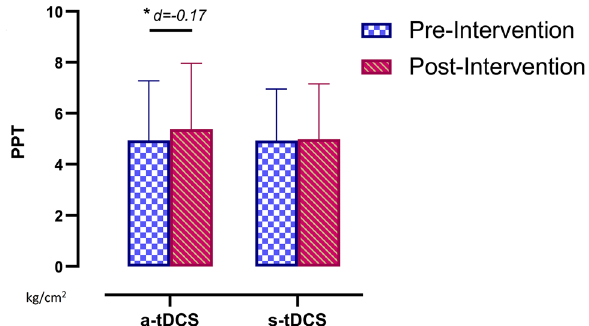
Figure 4. Within-group differences in pressure pain threshold over the rectus femoris. PPT pressure pain threshold, a‑tDCS active transcranial direct current stimulation ; s‑tDCS sham transcranial direct current stimulation.